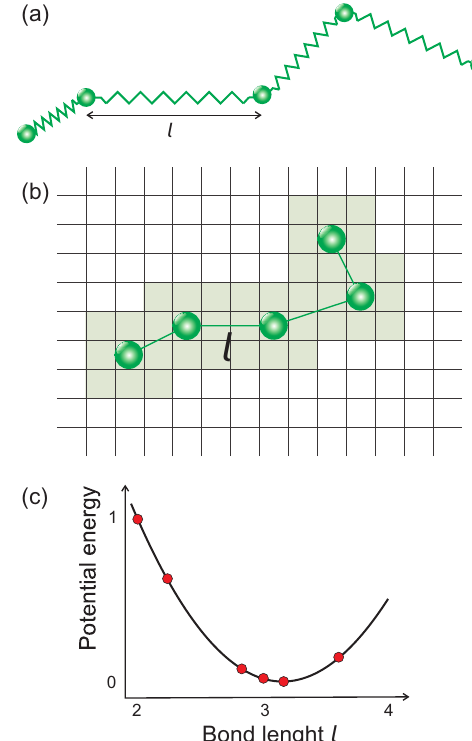
Figure 1. ( a ) Scheme of continuum bead-spring model; ( b ) lattice bond fluctuation model in 2D; and ( c ) potential energy of bonds in 2D